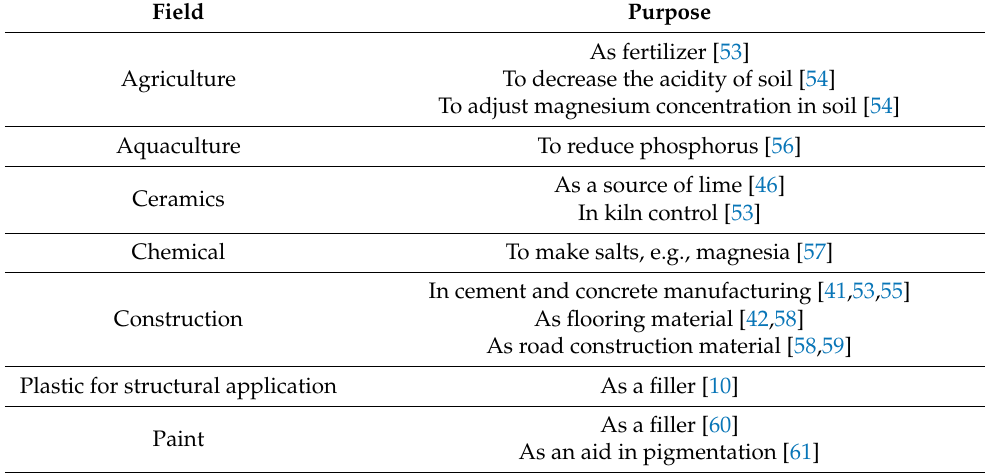
Figure 8. Packed dolomite for use as fertilizer (own photograph).